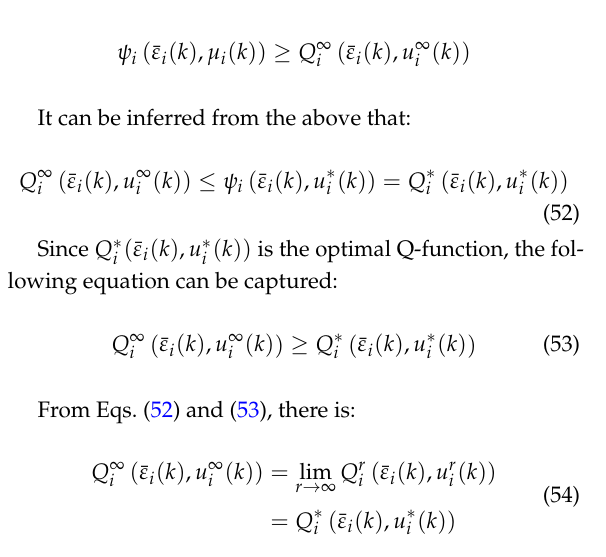
Fig. 1. The communication topology of